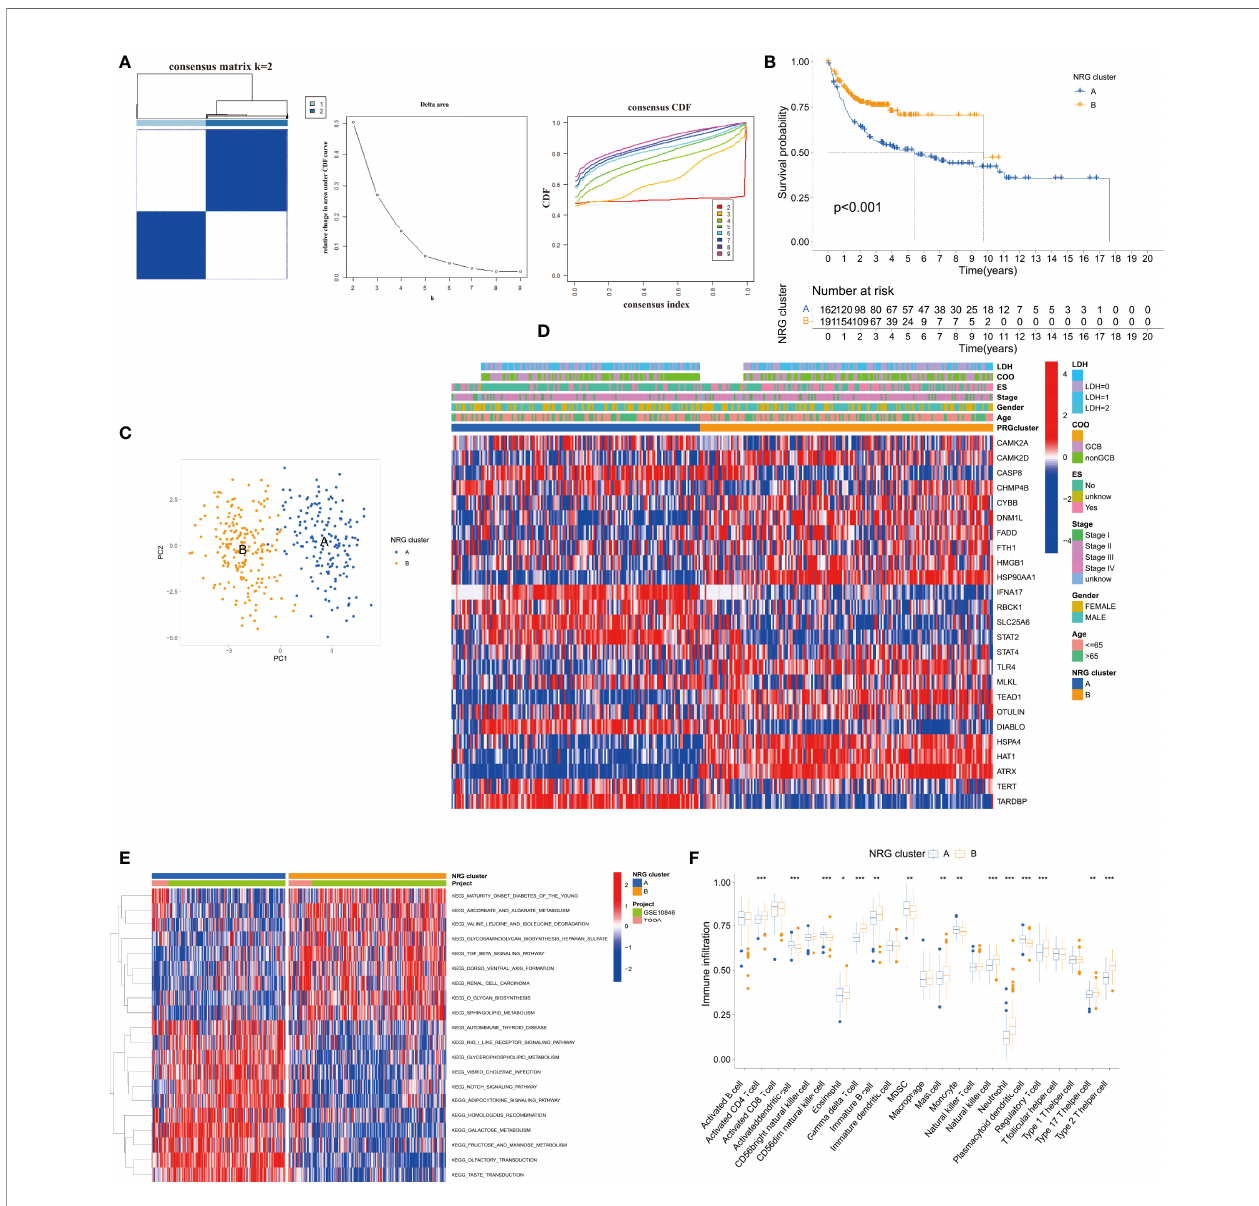
FIGURE 2 | Establishment and analysis of the NRG clusters. (A) The consensus matrix, delta area, and consensus CDF by cluster analysis based on NRGs. Two clusters would be best. (B) Kaplan – Meier survival curves of two NRG clusters ( p < 0.001). (C) Principal component analysis of NRG clusters. (D) Heatmap of NRG clusters and clinical data of DLBCL patients. Data of lactate dehydrogenases (LDH) and cell of origin (COO) are missing. (E) KEGG pathway enrichment analysis between NRG clusters by GSVA. (F) Immune in fi ltration between NRG clusters by ssGSEA. * p < 0.05, ** p < 0.01, *** p <